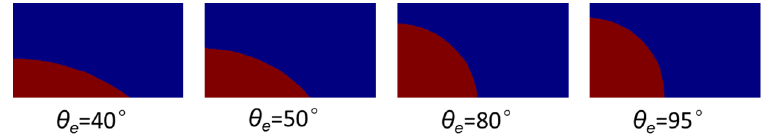
Figure 4. Shape of droplets of water ‐ based paint with different equilibrium contact angles.